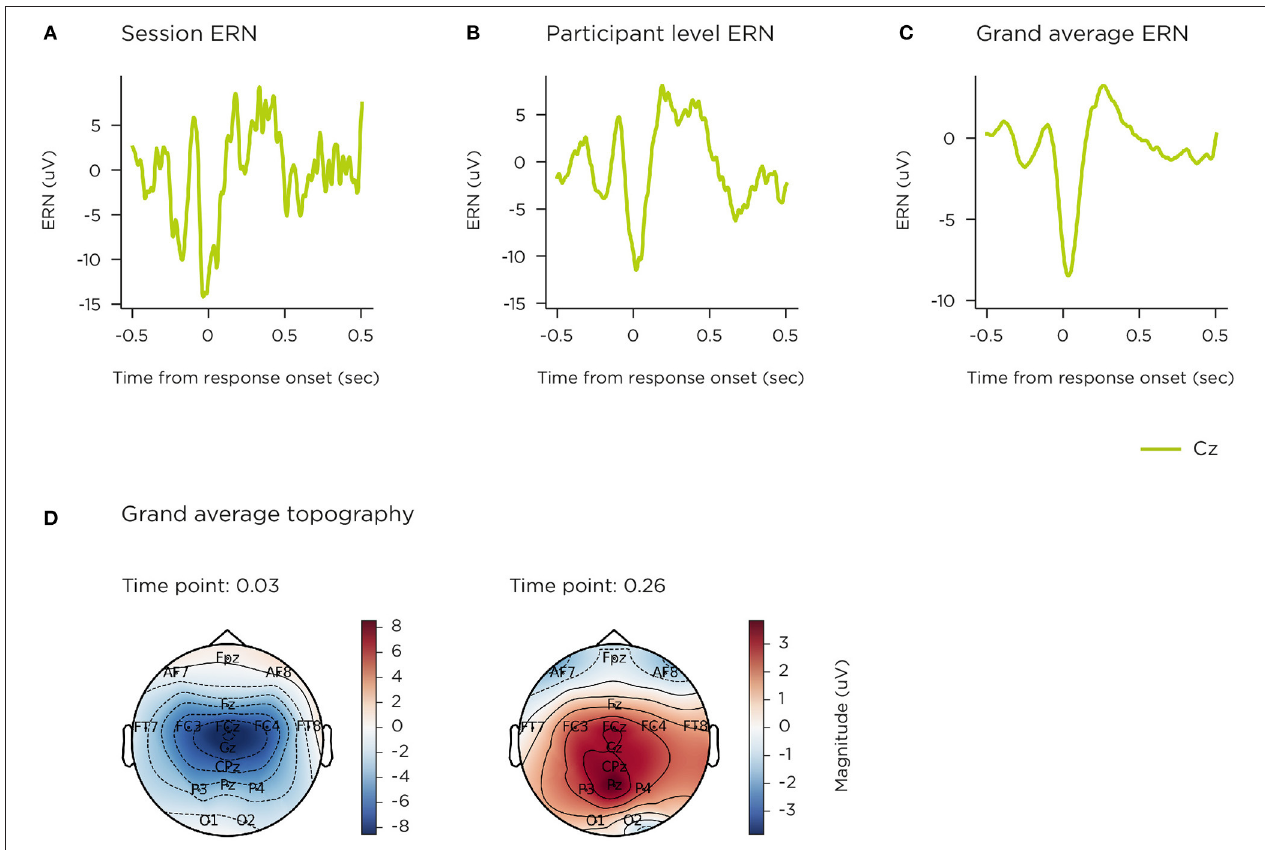
FIGURE 9 | ERN. (A) single-session median; (B) single-participant mean; (C) grand mean; (D) grand mean topographies selected at ERP peak